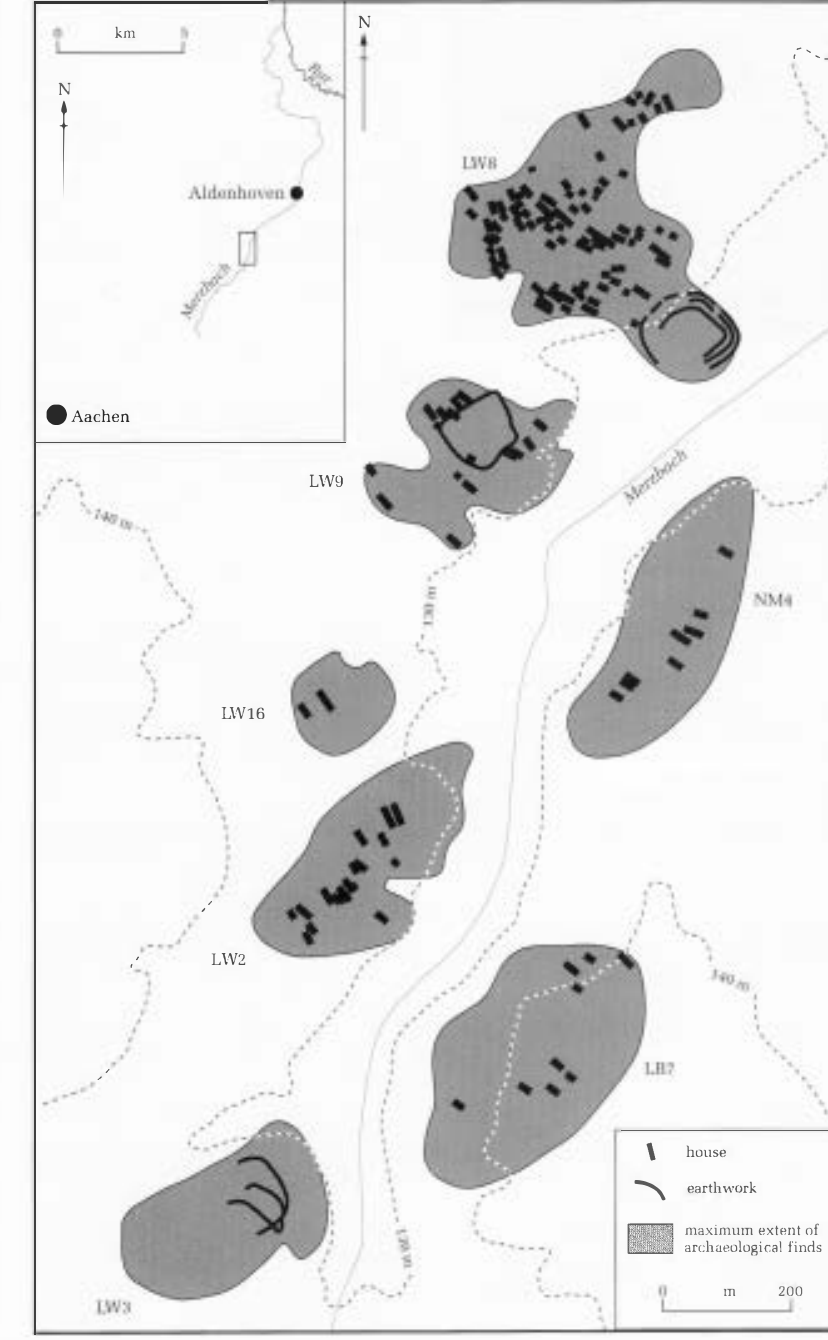
Figure 1 The distribution of Neolithic Linear Potte1y (Bandkeramic) settlements in the middle Merzbach